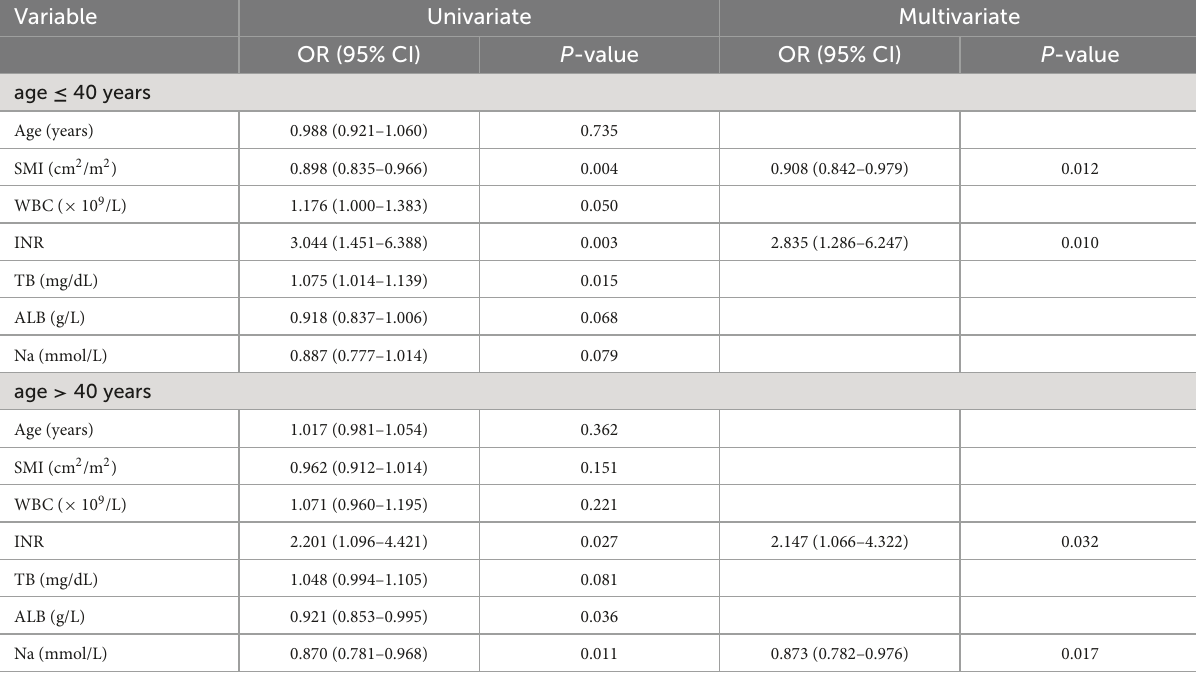
TABLE 3 Univariate and multivariate regression models in different age subgroups in male acute-on-chronic liver failure (ACLF) patients. Variable Univariate Multivariate